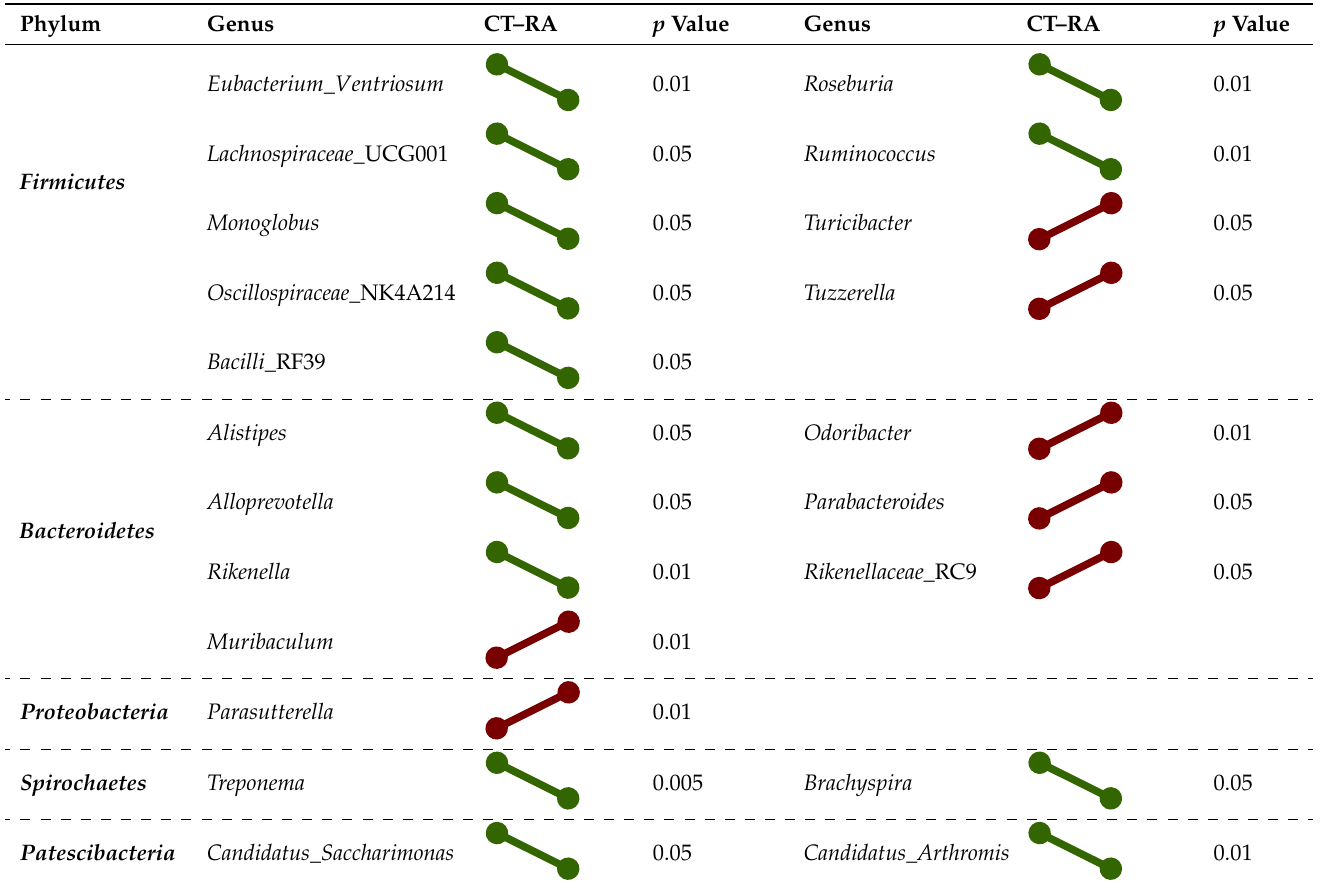
Table 2. Differentially enriched taxa in mice with rheumatoid arthritis and healthy controls.